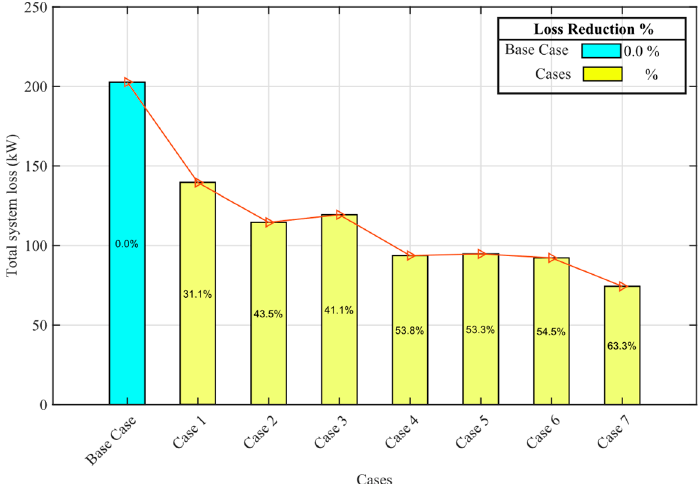
Figure 6. Loss reduction improvement of the 33-node test DS for all cases.